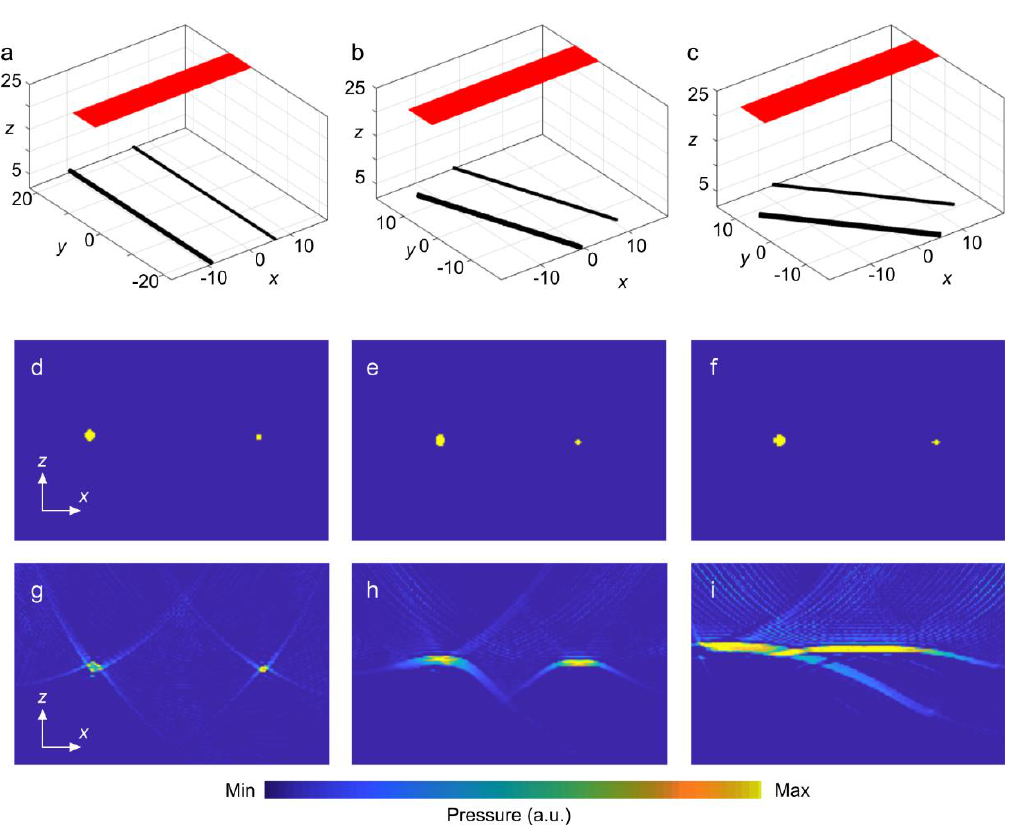
Figure 5. Shadow effect of the imaging target with an angular orientation. ( a ) Two cylinders are perpendicular to L7-4, ( b ) the angle between two cylinders and L7-4 is 60 degrees, and ( c ) the angle between two cylinders and L7-4 is 45 degrees. ( d – f ) Cross-section images of initial pressure, ( g – i ) are cross-sections of the PA reconstructed image for ( a – c ) digital phantoms.